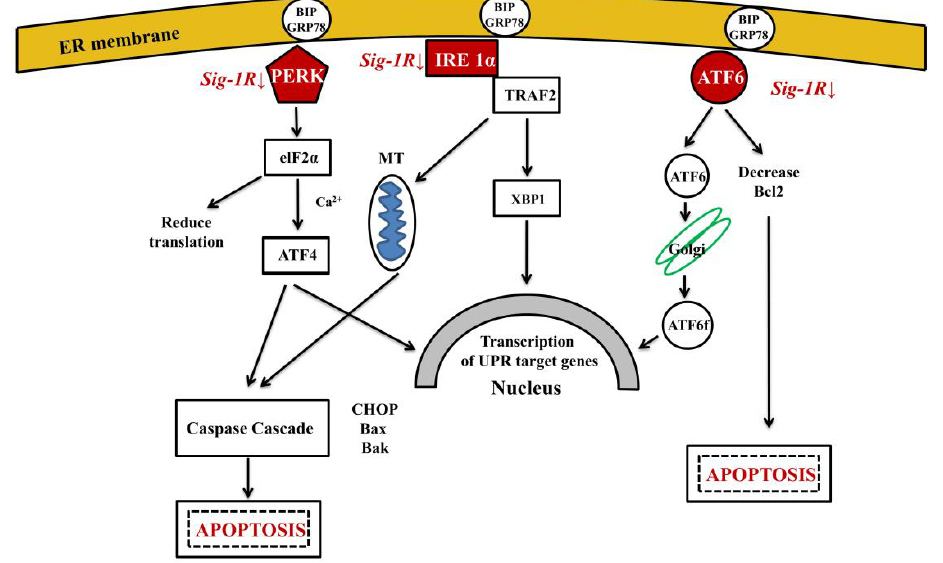
Figure 3. Three signal pathways of ER-stress activate UPR. ER chaperone GRP78 under normal conditions binds all the three ER-stress sensors (PERK: protein kinase RNA like ER-kinase; IRE1 α : inositol requiring enzyme 1 α ; ATF6: activating transcription factor 6). Under ER-stress GRP78 dissociates from sensors. PERK and IRE1 α will be phosphorylated and oligomerized, ATF6 translocates to the Golgi (Abbreviations: eIF2 α : eukaryotic translation initiation factor 2 α ; XBP1: X-box binding protein 1 (spliced form); TRAF2: TNF-associated factor-2; ATF4: transcriptional activator factor-4; MT: mitochondrium). ATF6, ATF4 and XBP1 activate UPR target genes to enhance the capacity of the ER to cope with unfolded proteins. Activation of Sig-1R inhibits the three branches of UPR.